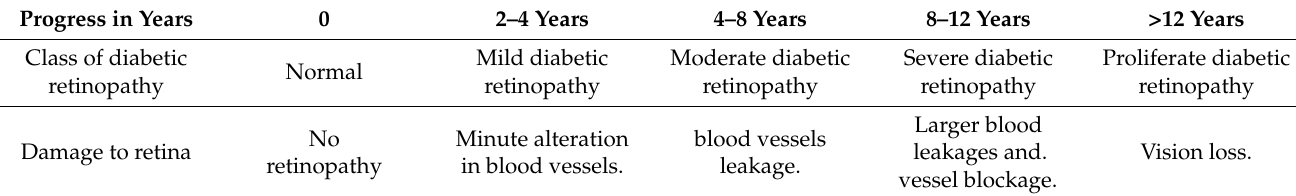
Table 3. Classes of diabetic retinopathy.